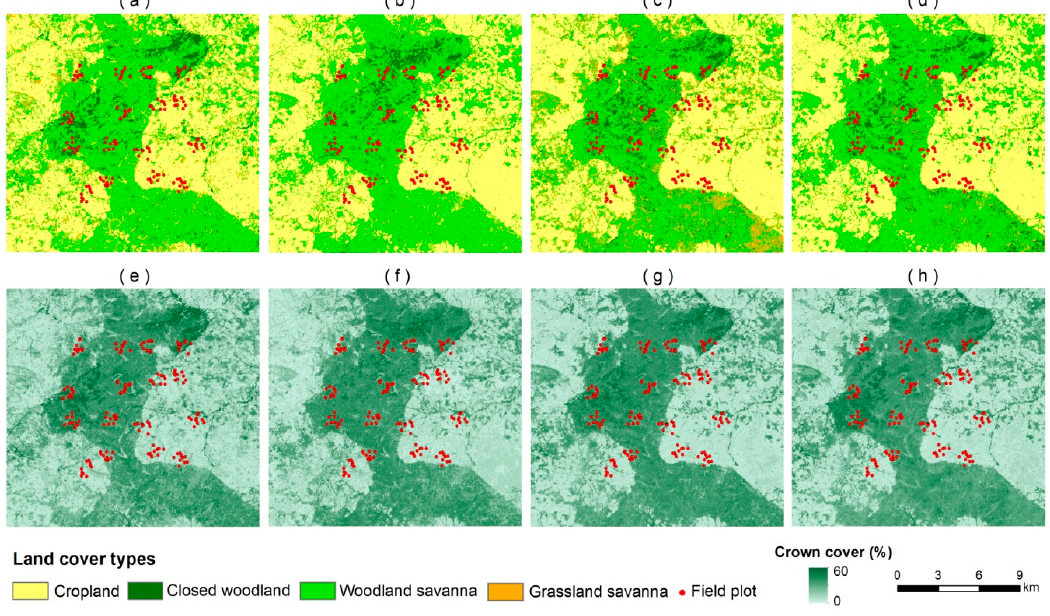
Figure 9. Land cover maps based on ( a ) 12 November 2013 Landsat 8 image; ( b ) 8 June 2014 Landsat image; ( c ) seasonal features without burnt area removal and ( d ) seasonal features after burnt area removal, and tree crown cover maps based on ( e ) 12 November 2013 image; ( f ) 8 June 2014 image; ( g ) seasonal features without burnt area removal; and ( h ) seasonal features after burnt area removal.